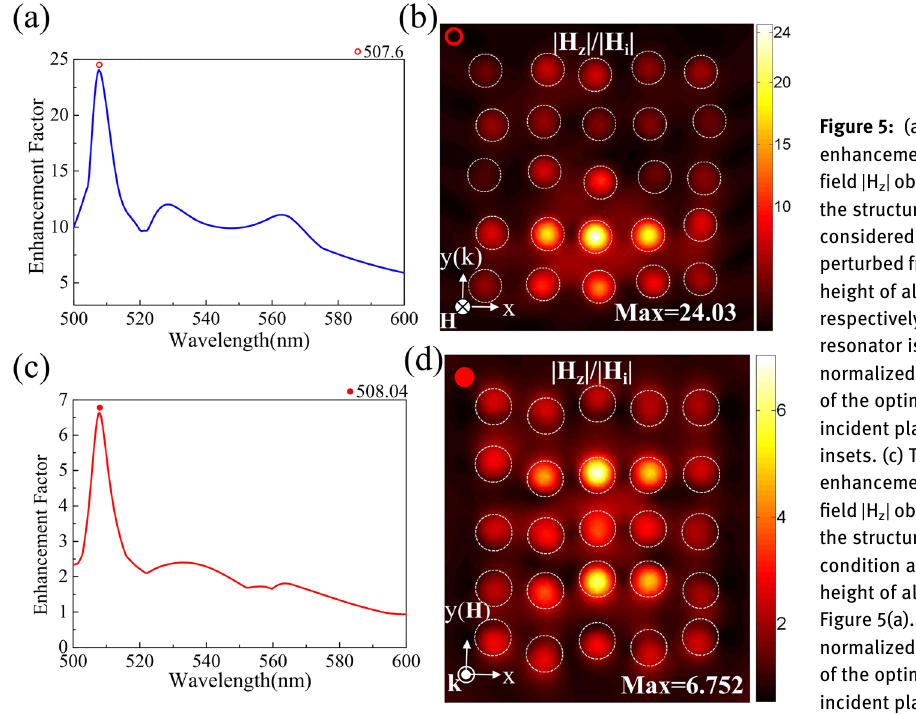
condition as shown in d). The radius and height of all resonators are the same as Figure 5(a). (d) The corresponding normalized magnetic fi eld | H z | distributions of the optimized result (508.04 nm). The incident plane waves are indicated in the